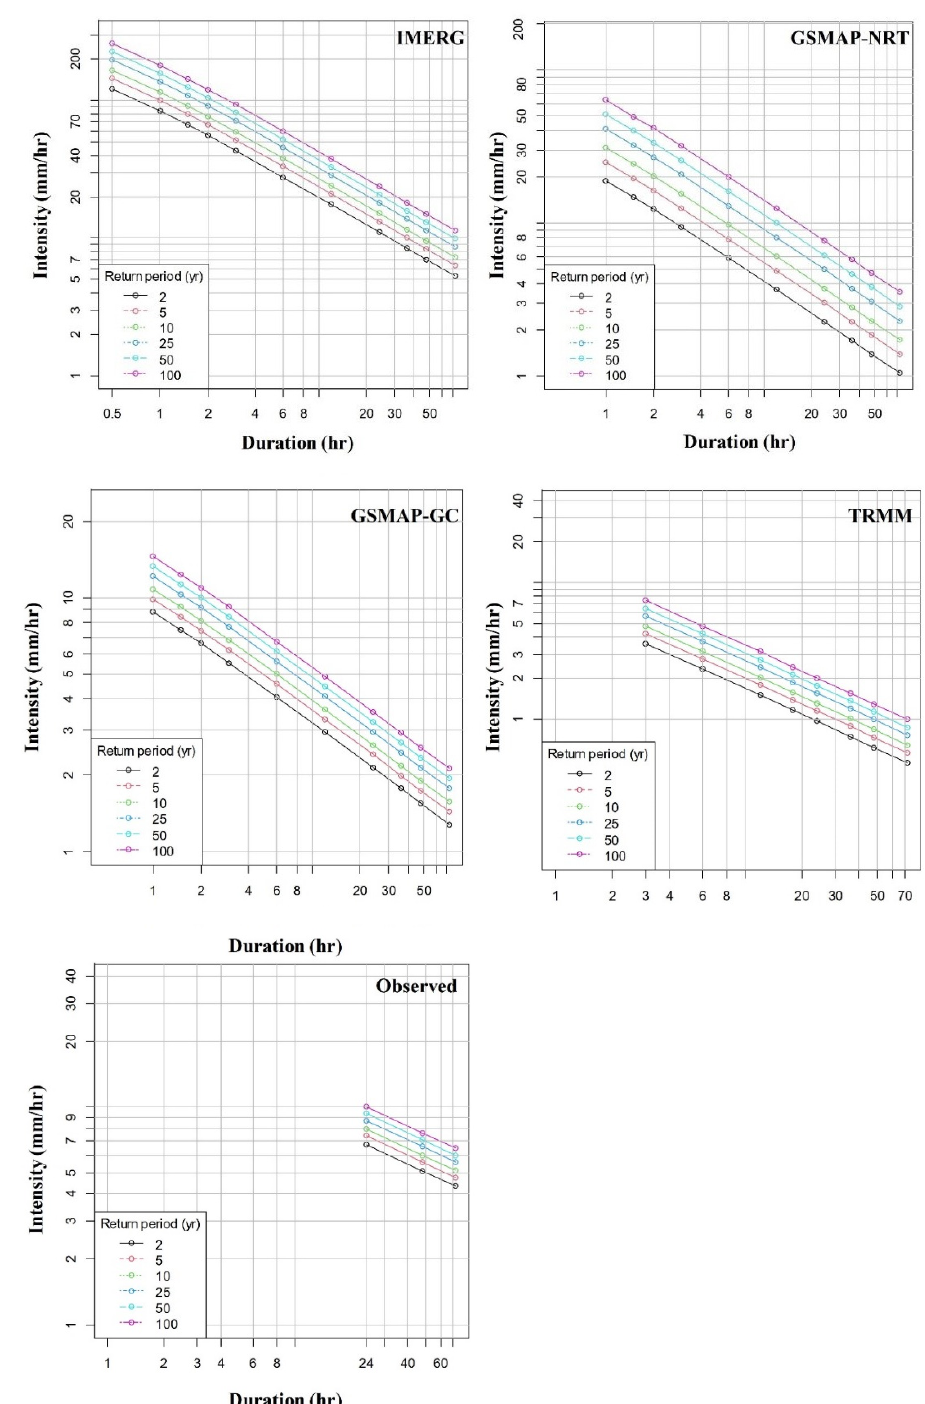
Figure 6. IDF Curves at YIA using satellite and observed precipitation datasets for 2015–2020 based on the Sherman method.